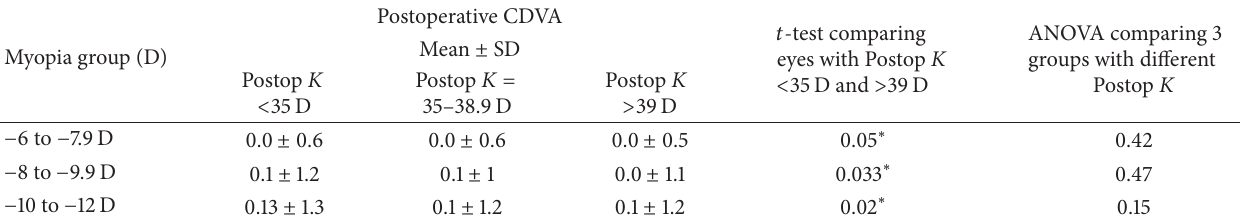
Table 3: Postoperative CDVA stratified by postoperative keratometry.